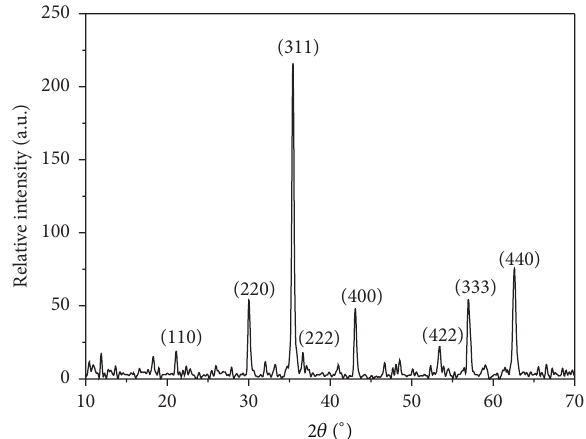
Figure 1: The XRD graph of 𝛾 -Fe 2 O 3 powder prepared at 60 ∘ C and pH 6.0 for 6 h.